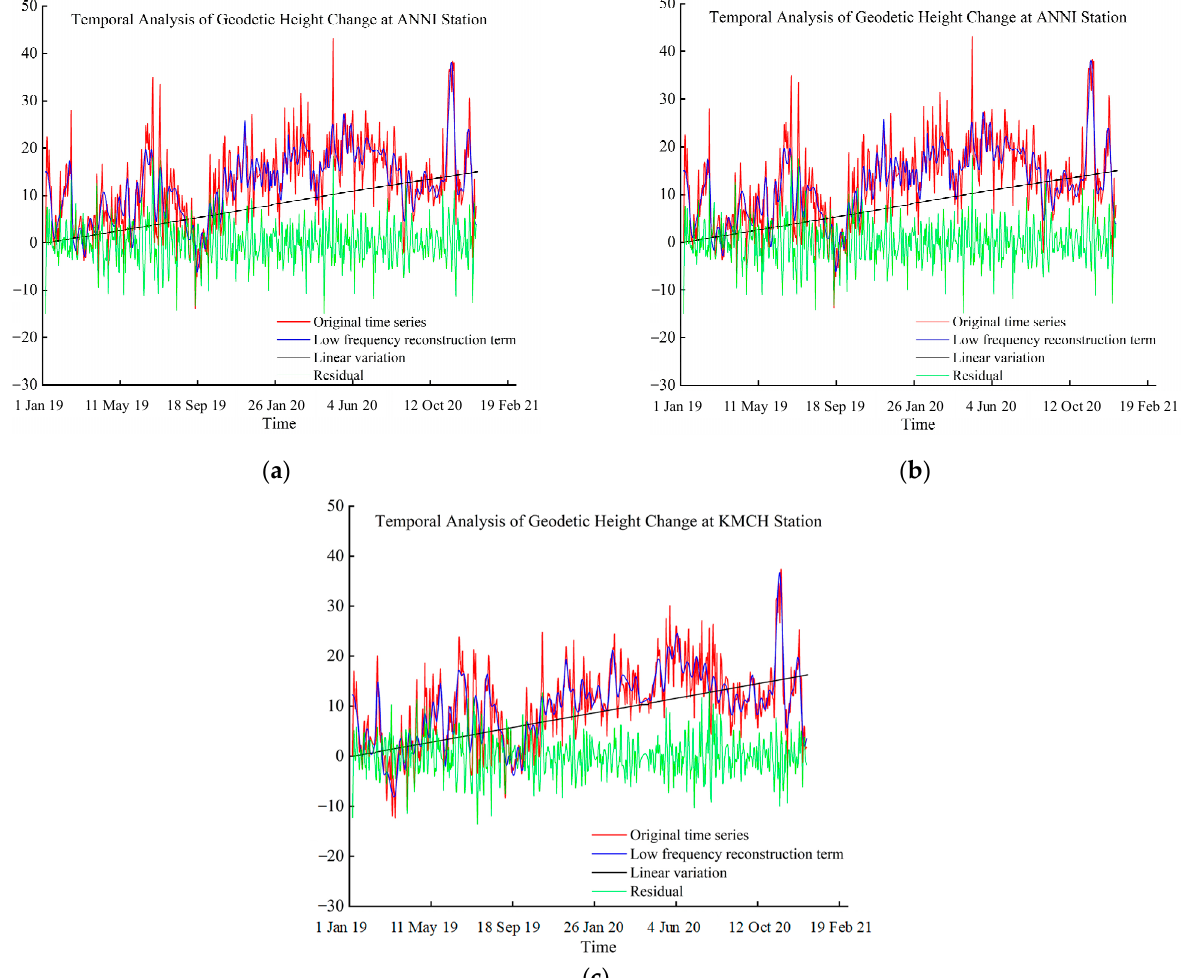
Figure 5. CORS sites time series. ( a ) Temporal analysis of geodetic height change at ANNI station; ( b ) Temporal analysis of geodetic height change at CHG0 station; ( c ) Temporal analysis of geodetic height change at KMCH